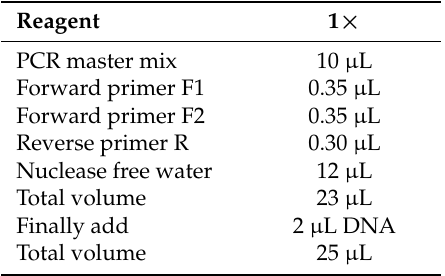
Table 2. Preparation of PCR cocktail for LDLR-rs688C > T polymorphism.